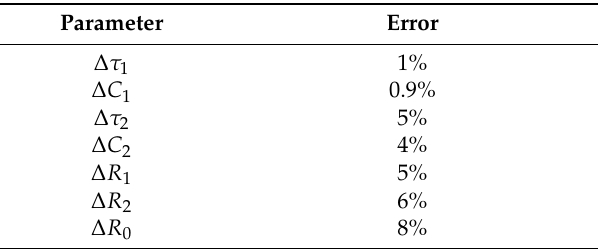
Table 2. Maximum relative errors of estimated